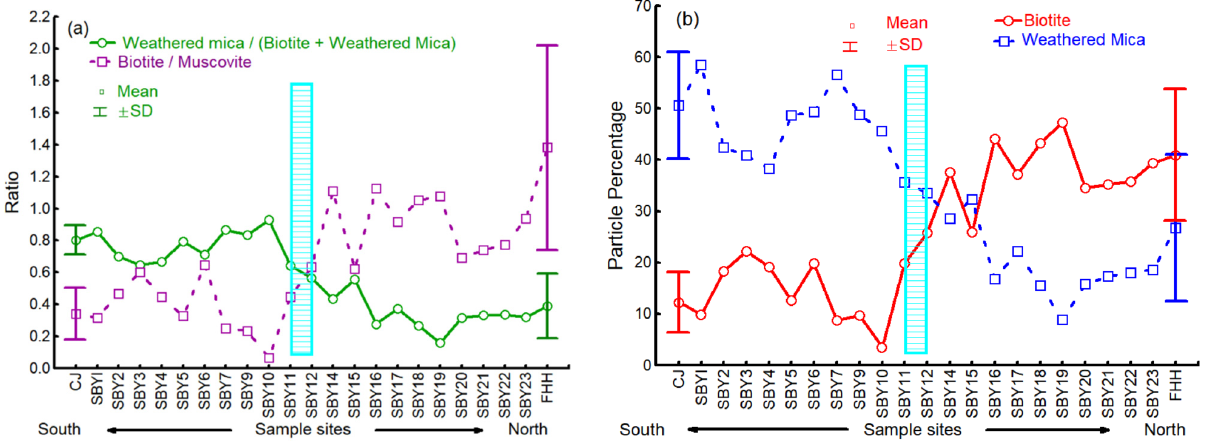
Figure 9. Variation in the mica-specific diagnostic indices in the very fine sand fraction of coastal sediments between the Yangtze River Estuary (CJ) and the ancient Yellow River Estuary (FHH) together with the Subei littoral plain area. ( a ) shows the variation of paticle percentage ratio of weathered mica to the sum of biotite and weathered mica (in green), and the variation of paticle percentage ratio of biotite to muscovite (in purple). ( b ) shows the variation of paticle percentage of biotite (in red) and weathered mica (in blue).